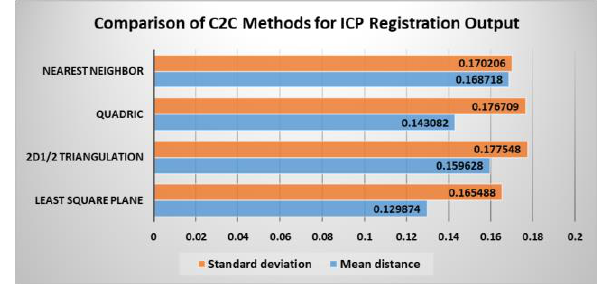
Figure 28. Comparison of mean distance and standard deviation Figure 27. Comparison of mean distance and standard deviation values for the C2C distance computation for ICP registration values for the C2C distance computation for MBBC registration method method